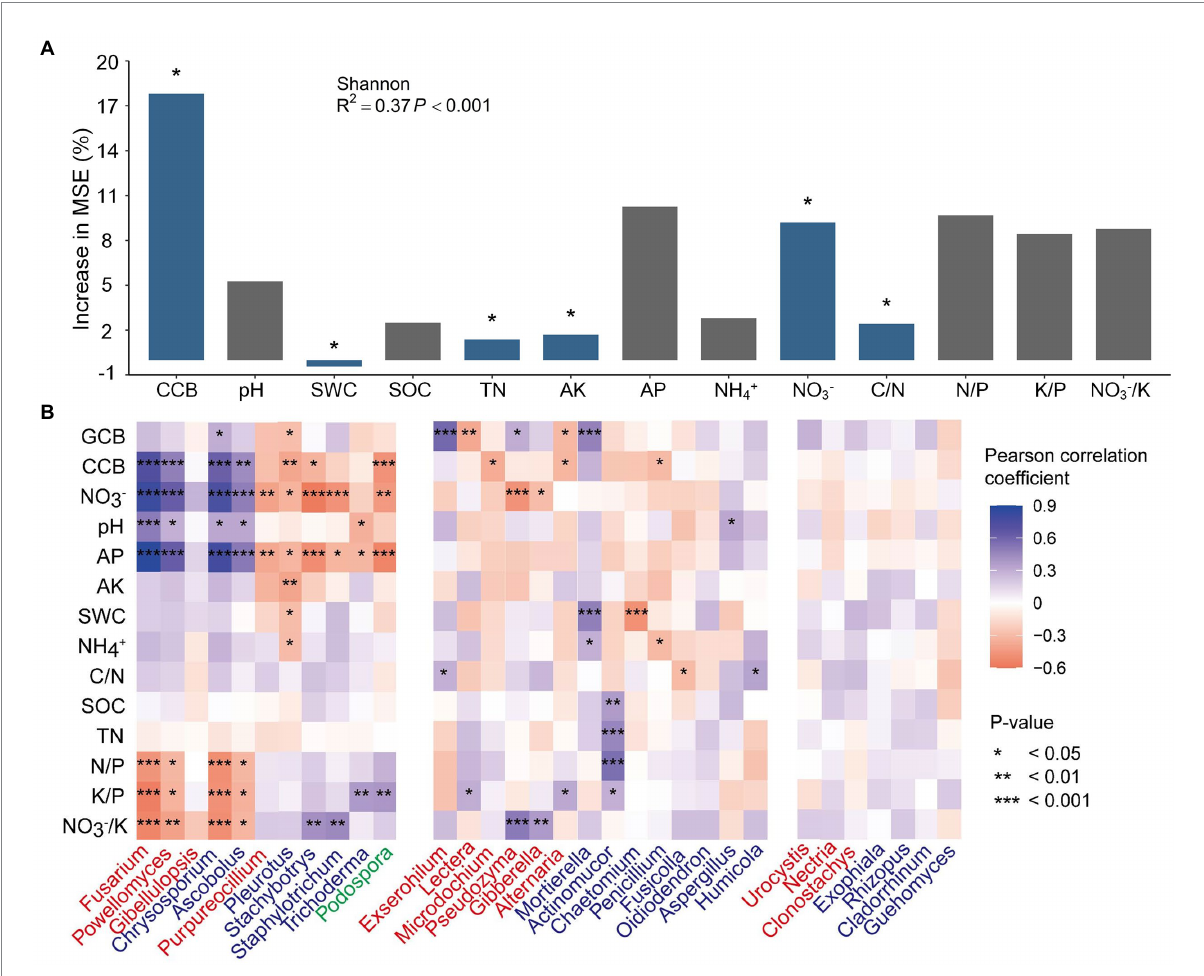
FIGURE 5 Random Forest mean predictor importance (% of increase in MSE) of the environmental factors as predictors of Shannon index (A) , and Pearson’s correlation coefficient between relative abundances of the differential fungal genera and environmental factors (B) . Blue or red color in the square indicates a positive or a negative correlation, respectively, and the shade of the color indicates the magnitude of the correlation coefficient. Fungal genera in red, blue, and green fonts represent the functional guilds: pathotrophs, saprotrophs, and symbiotrophs, respectively. Asterisks indicate the significance of the correlation at p ≤ 0.05 (*), 0.01 (**), or 0.001 (***). GCB, grain crop biomass; CCB, cover crop biomass; SWC, soil water content; SOC, soil organic carbon; TN, total nitrogen; AP, available phosphorus; AK, available potassium; C/N, the ratio of SOC and TN; N/P, the ratio of TN and AP; K/P, the ratio of AK and AP; NO 3 − /K, the ratio of soil nitrate and